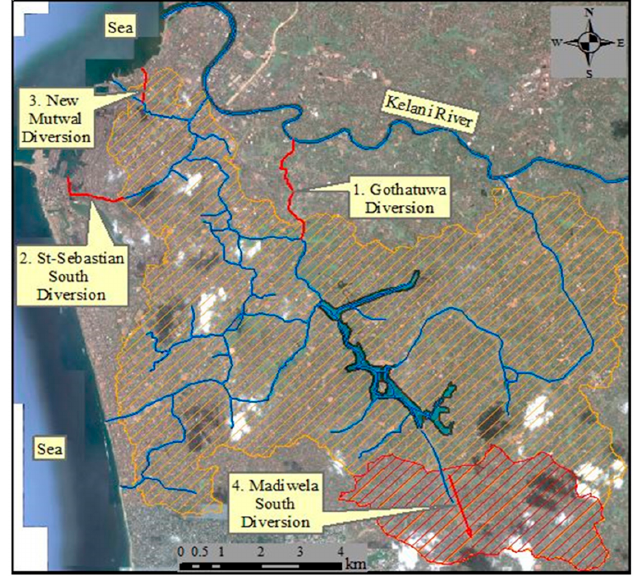
Figure 12. Locations of the proposed countermeasures.